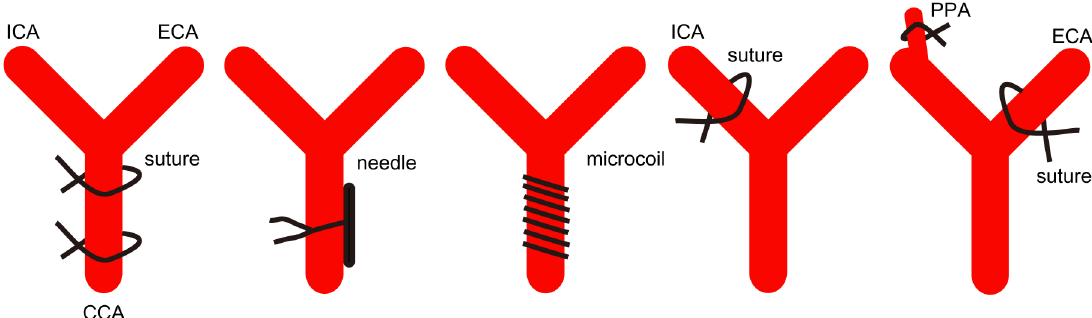
Figure 3. Experimental models of OIS suggested in the current review article. There are various methods of developing experimental models of OIS using unilateral or bilateral sutures, needles, and microcoils in mice and rats. Occlusion sites also vary depending on the studies, as discussed in Section 2. CCA, the common carotid artery; ICA, the internal carotid artery; ECA, the external carotid artery; PPA, the pterygopalatine artery.